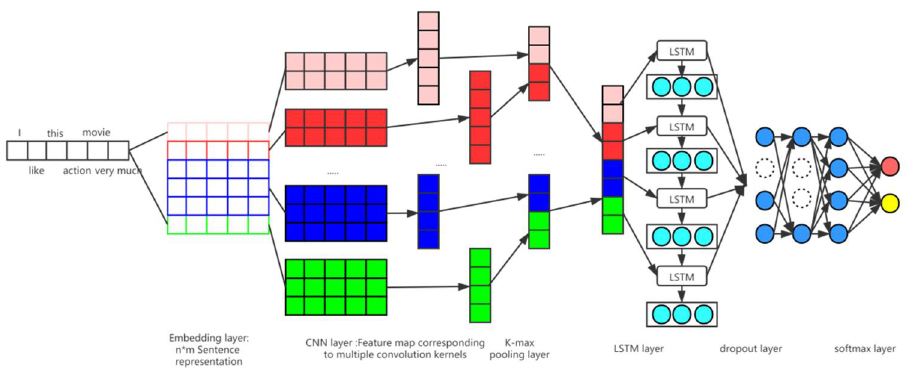
Figure 6. User portrait model based on CNN + LSTM.